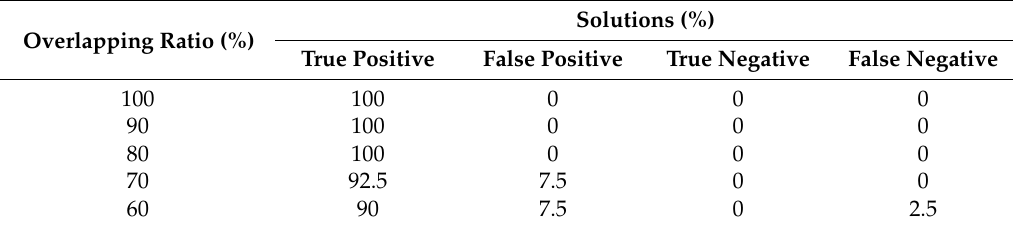
Table 2. Solutions that were generated by the improved